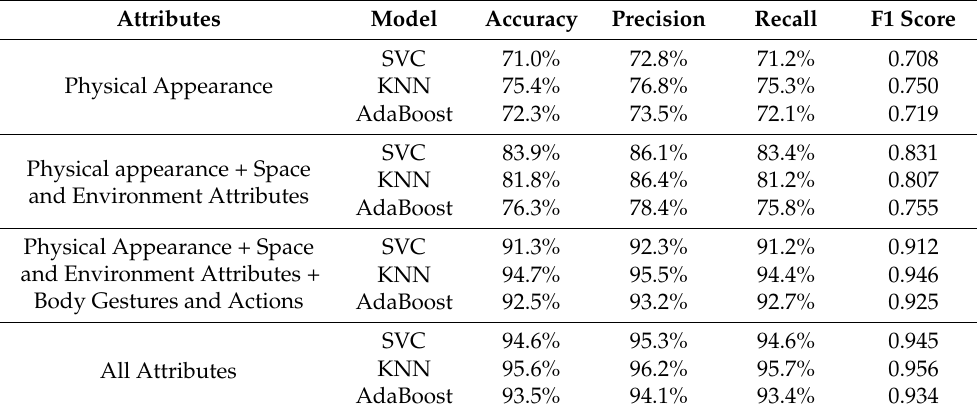
Table 21. Results for the combined sets of attributes.